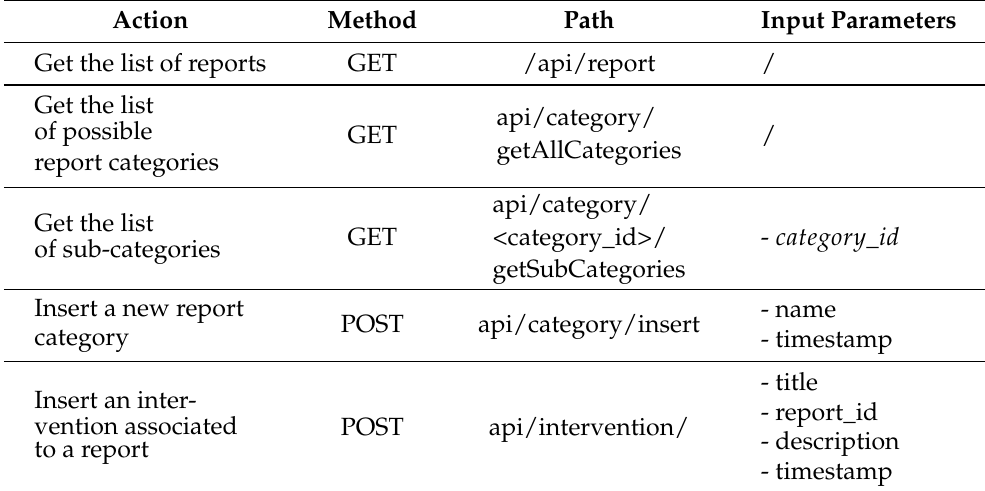
Table 3. REST API for reports, interventions, operators, and survey.